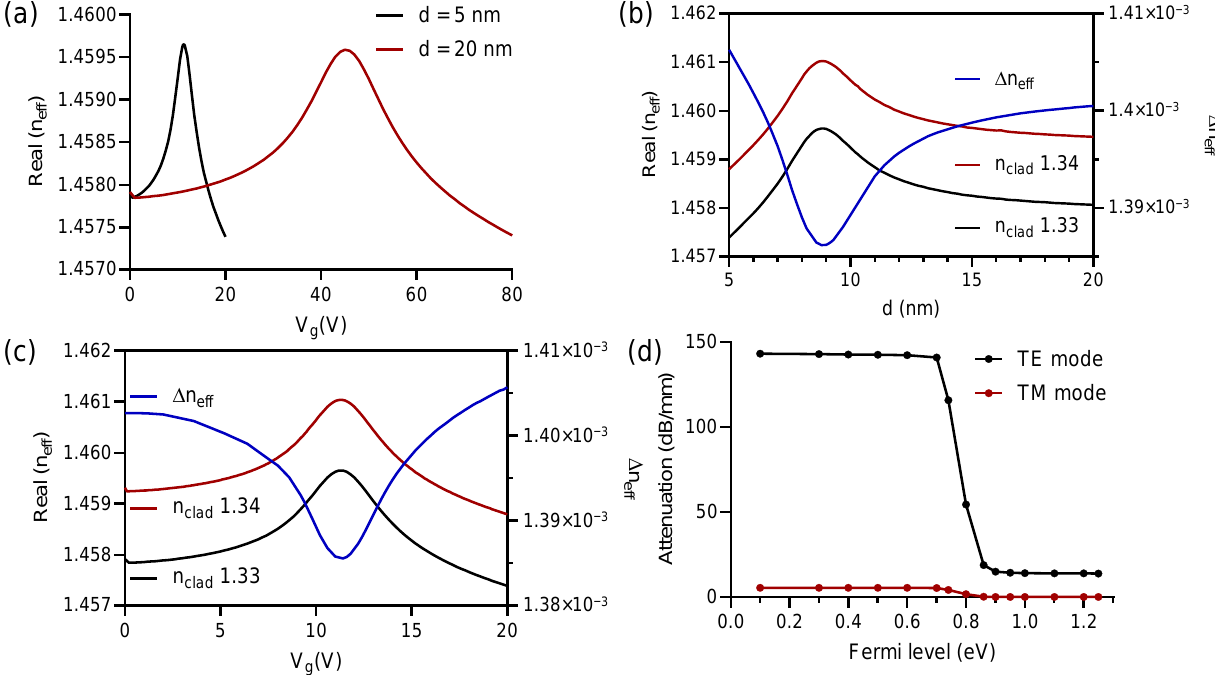
Figure 6. ( a ) Real part of the effective refractive index as a function of the Vg for 5 nm and 20 nm thickness in the dielectric between the two monolayers of graphene. ( b ) Analysis at V g = 20 V of the real part of the effective refractive index as a function of the d variation, for cladding values at 1.33 and 1.34, and the ∆ n ef f as a function of the reference arm. ( c ) Analysis at d = 5 nm of the real part of the effective refractive index as a function of the V g variation, for cladding values at 1.33 and 1.34, and the ∆ n ef f as a function of the reference arm. ( d ) Attenuation as a function of the Fermi level variation, for TE and TM propagation